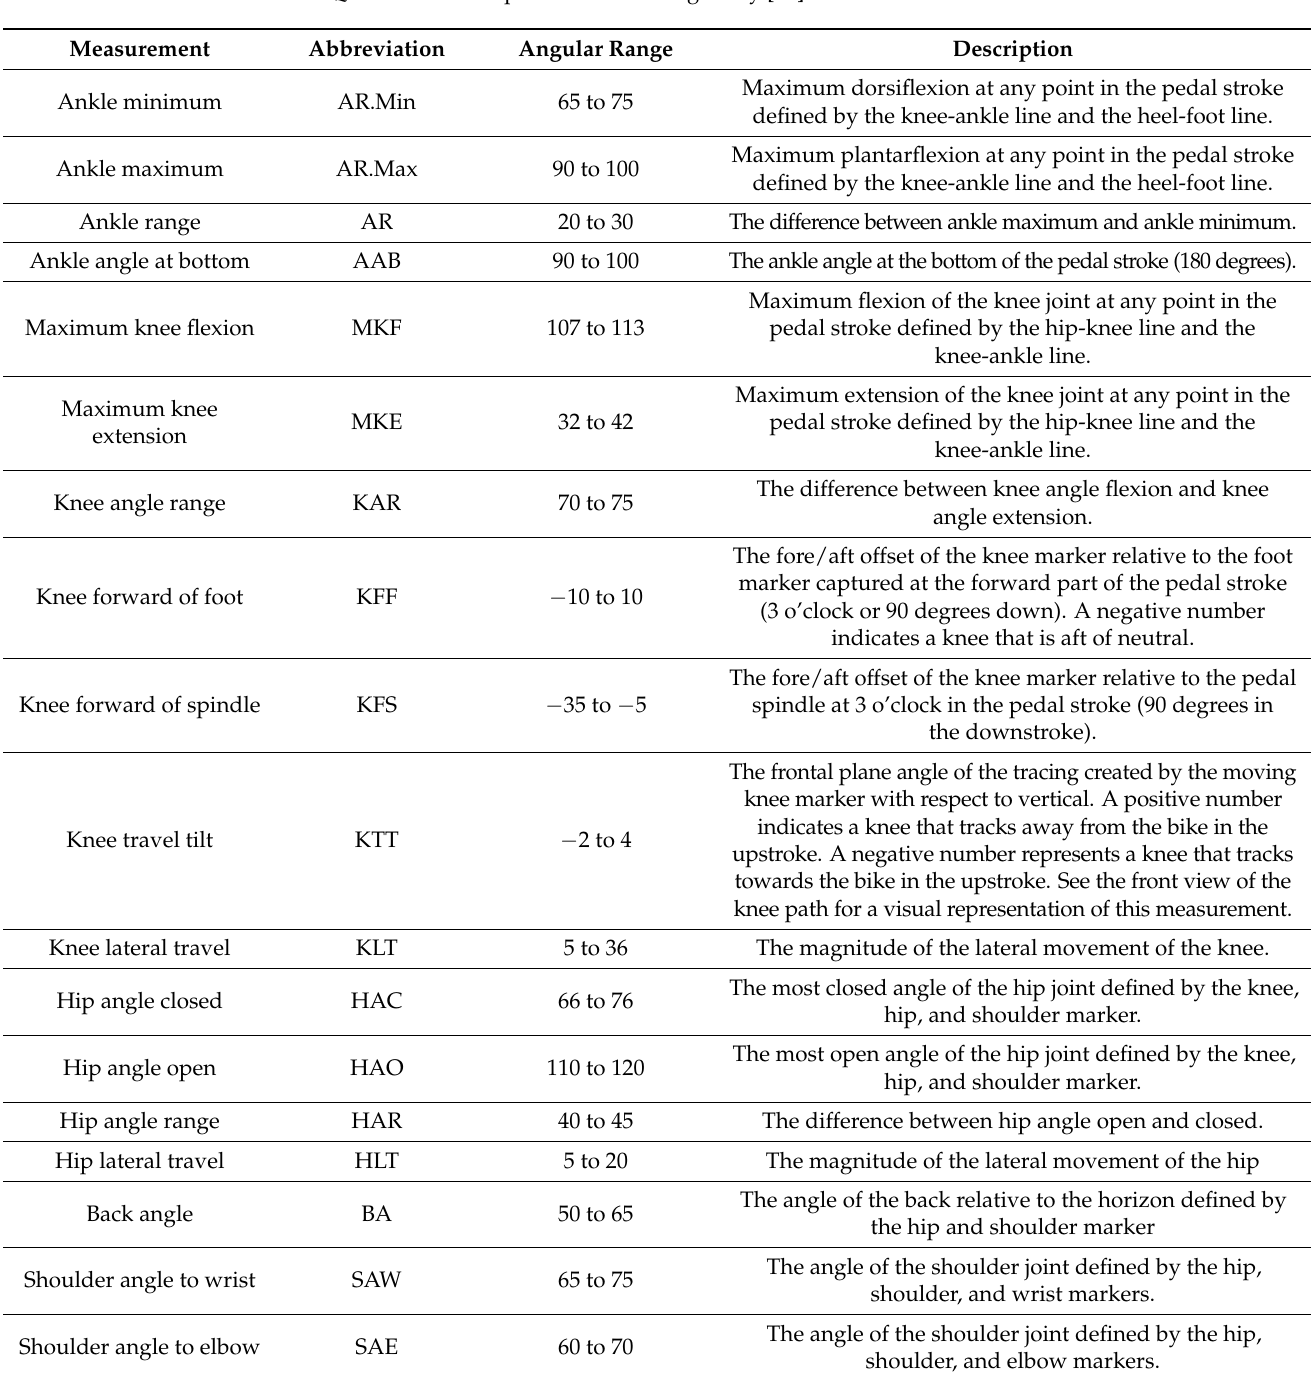
Table 2. Recommended measurements and joint angular ranges for cycling 3D kinematics